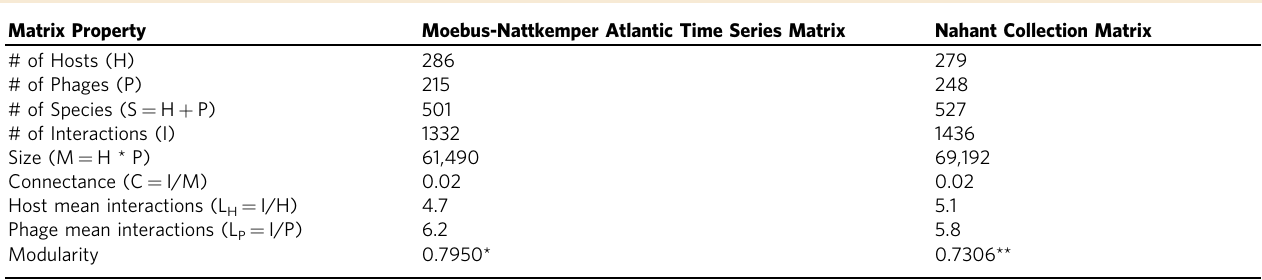
Fig. 2 The nested-modular structure of environmental phage – host interaction networks re fl ects multiple drivers. a Network analysis of the Nahant Collection infection matrix shows an overall nested-modular interaction structure and abundance of one-to-one infections. b Re-organization of the interactions in light of host phylogenetic and phage genomic diversity reveals that modular structure re fl ects the in fl uence of host species, phage genera, phage host range strategies, and bloom dynamics. In both panels bacteria are represented as rows and phages as columns; both panels show the same 248 phages and the subset of 259 Nahant Collection hosts which were infected in the host range assay by one of the 248 phages and for which genomes were also available (see details on host subsets in Supplementary Data 1, sheet readme); in both panels a and b, all interactions within each matrix are colored according to BiMat leading eigenvector modules (the fi ve largest groups are shown, for example, as blue, green, red, purple, and light yellow); in panel b bacterial strains are ordered based on phylogeny of concatenated single copy ribosomal protein genes, with leaf colors representing species; in panel b phages are ordered based on manual sorting of VICTOR genus-level trees into groups by morphotype irrespective of their higher order clustering (where VIC-genera of different morphotypes can be intermingled; VICTOR trees represent Genome BLAST Distance Phylogenies (GBDP) based on concatenated protein sequences for each phage genome, with branch lengths representing intergenomic distances scaled in terms of the GBDP distance formula d 6 ; each of the 49 phage VIC-genera are represented as a distinct group indicated by a circle fi lled with the color representing the morphotype of the genus (purple: non-tailed; red: myovirus; yellow: podovirus; green: siphovirus); see Supplementary Data 8 for full original VICTOR phylogeny not sorted by morphotype). Underlying data are provided in Supplementary Data 1 and Source Data Fig. 2, see Methods for strain sets included in the analyses. Phage icon source: ViralZone www.expasy.org/viralzone, Swiss Institute of Bioinformatics. Source Data Fig. 2. Table 1 Comparison of Moebus-Nattkemper and Nahant matrix